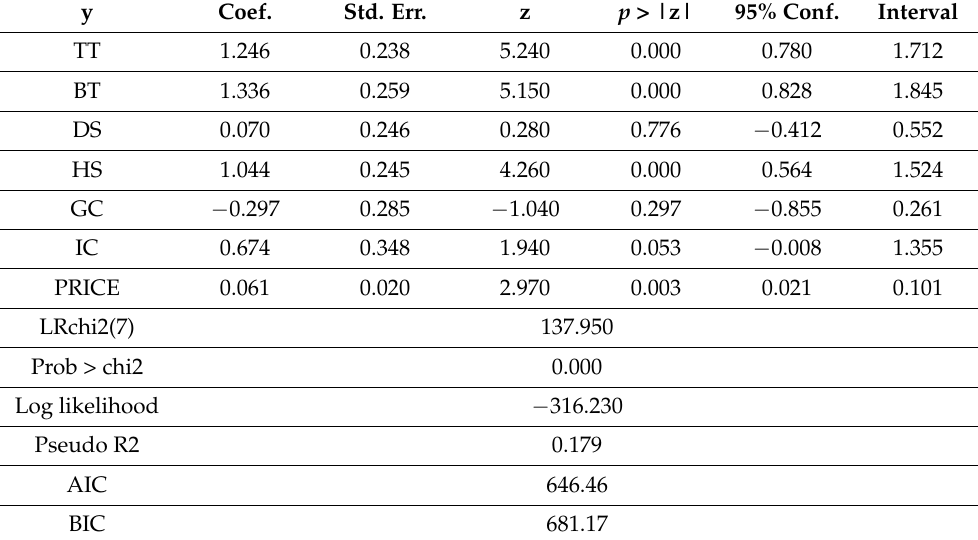
Table 4. Conditional logit